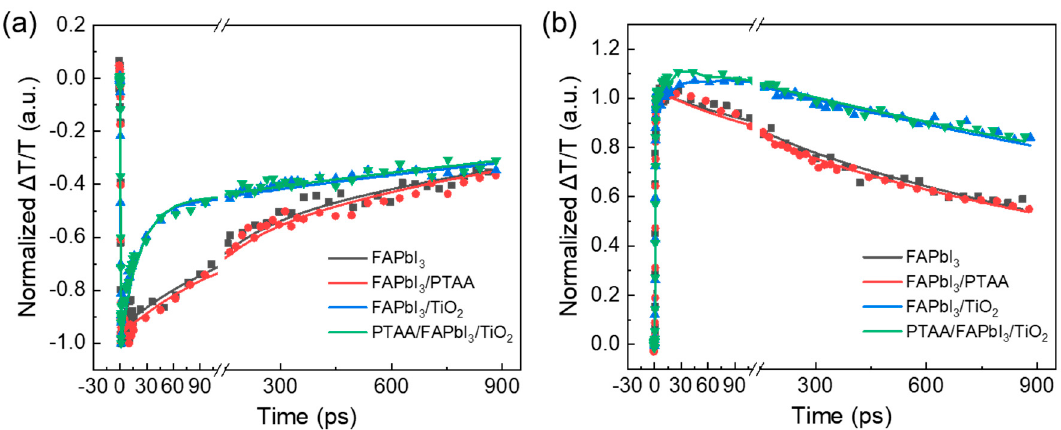
Figure 4. Experiment data of normalized ( a ) PA kinetic traces probed at 570 nm and ( b ) PB kinetic traces probed at 770 nm. All the measurements were carried out under the pump pulses of 400 nm with fluence of ≈ 3.5 µ J / cm 2 . The solid curves represent the fitting results. The fitting parameters are summarized in Table 1.